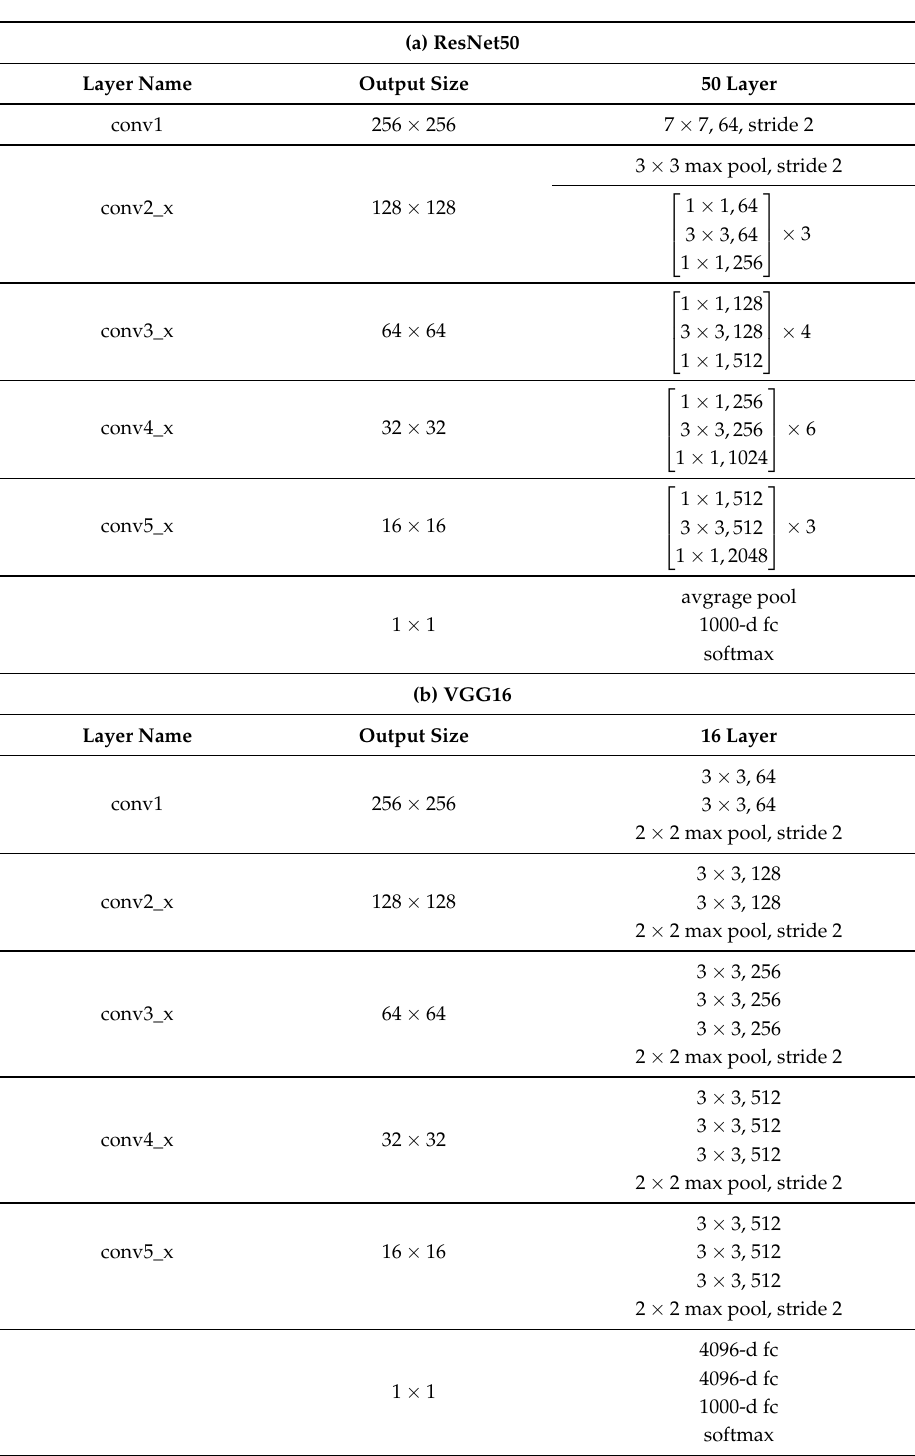
Table 1. Backbone